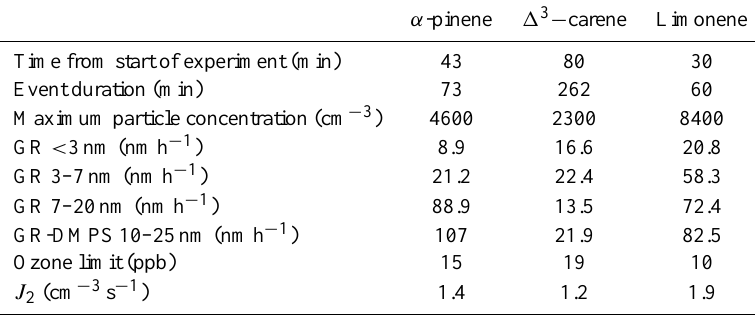
Table 3. Event characteristics and growth rates (GR) for negative ions and all particles (GR-DMPS), ozone at start of event and formation rates for negative 2-nm particles ( J 2 ) for all set one experiments α -pinene 1 3 − carene